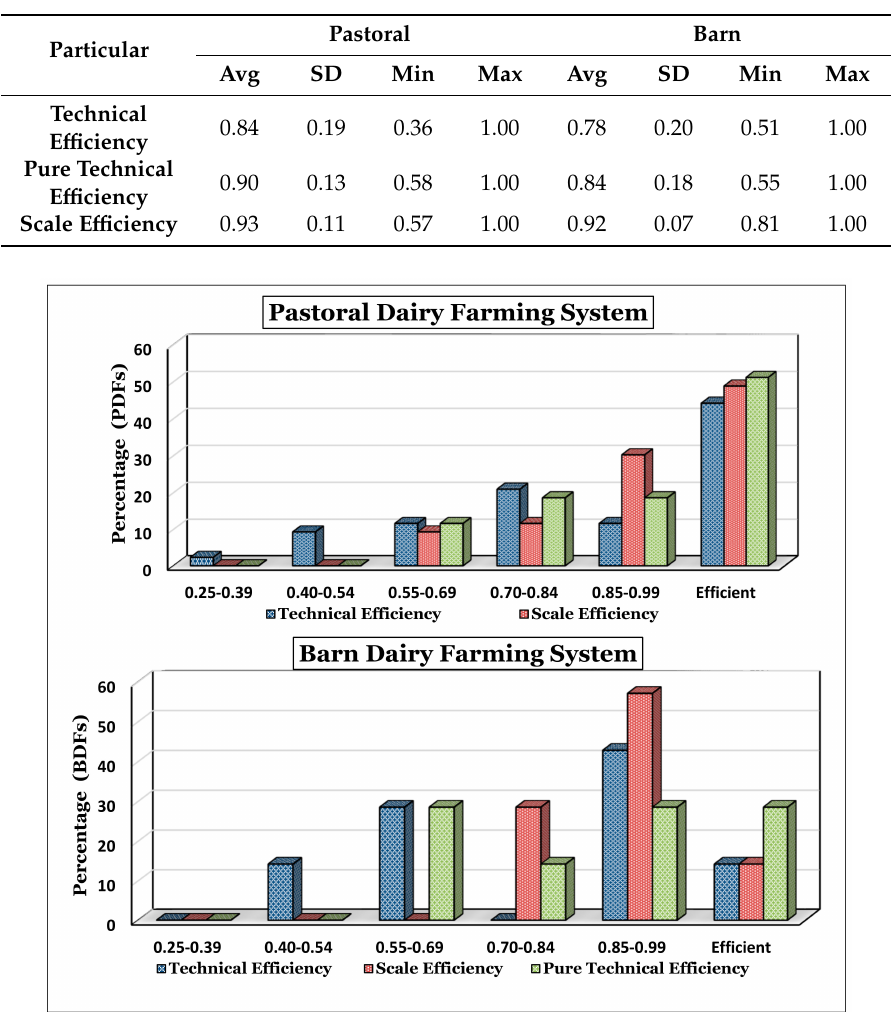
Figure 2. E ffi ciency score of pastoral (PDFs) and barn dairy farming systems